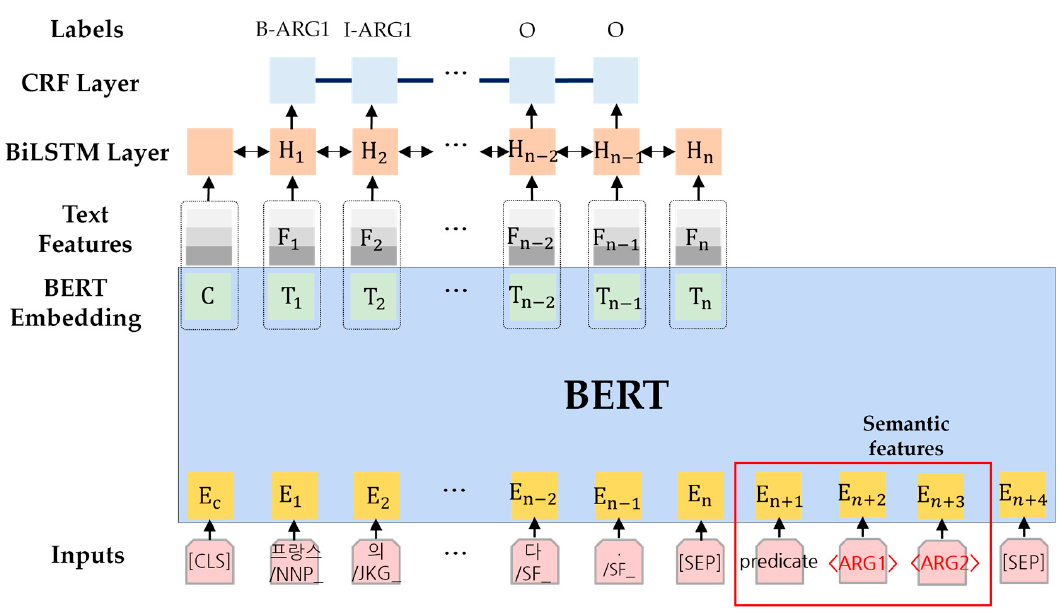
Figure 5. Architecture of our semantic role labeling model.